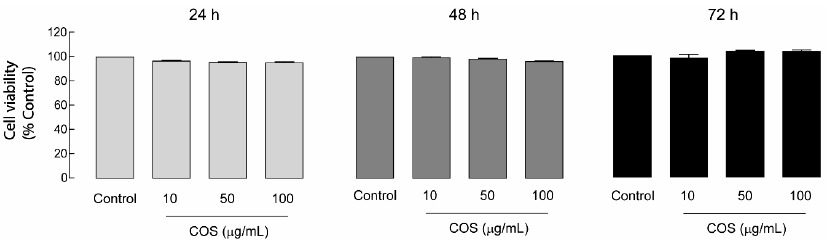
Figure 2. E ff ect of COS on MDCK cell viability. MDCK cells were seeded onto 96-well plates and incubated with COS at 0, 10, 50, or 100 µ g / mL for 24, 48, or 72 h. MTT assays were performed to evaluate the e ff ect of COS on MDCK cell viability. Data are expressed as mean of percent cell viability ± S.E.M. ( n = 3–4).